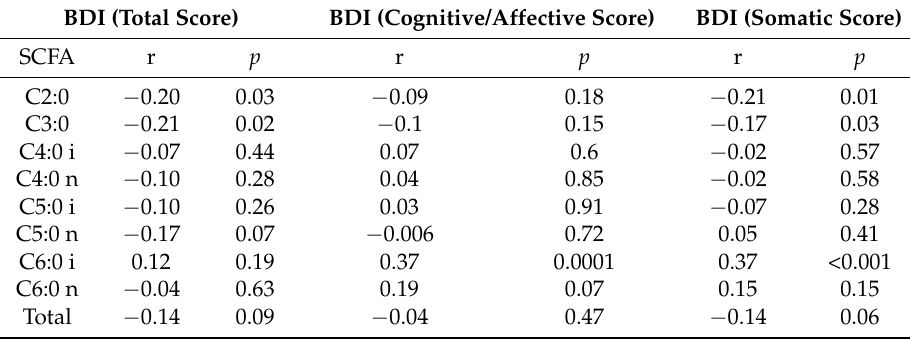
Table 3. Correlation between SCFAs concentration and BDI-I